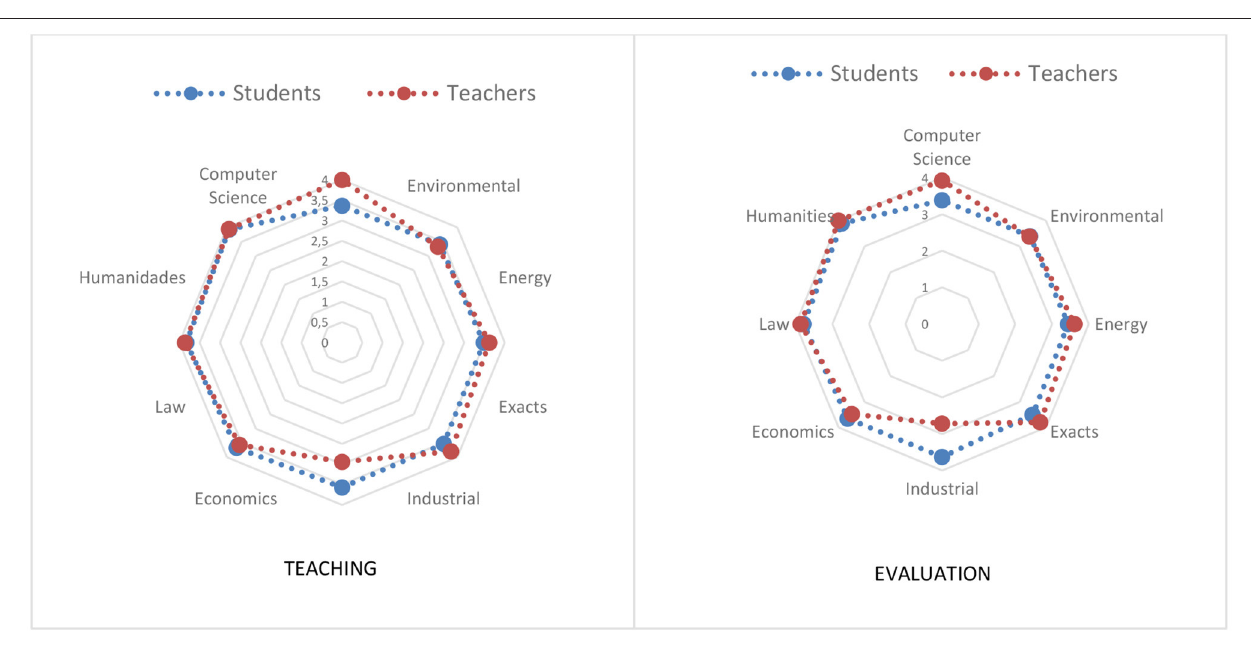
FIGURE 4 | Teaching and evaluation of ARC through an essay